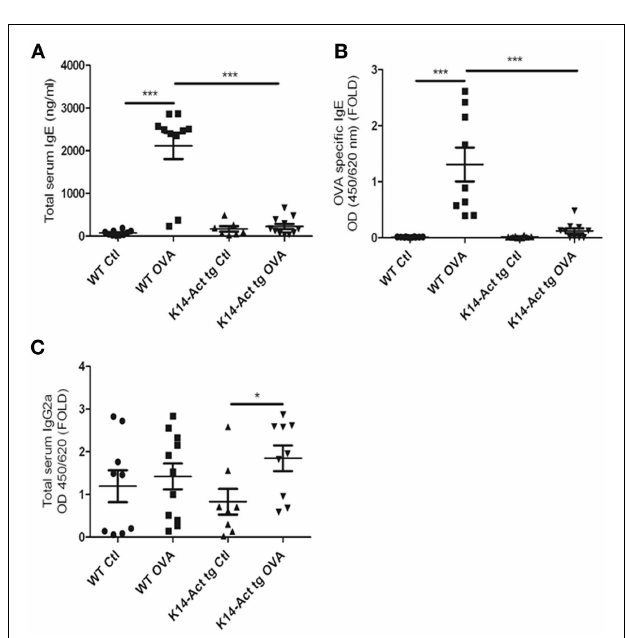
FIGURE 5 |Activin overexpression inhibits the production of IgEs after OVA treatment .WT and K14-Act mice treated with OVA or vehicle were sacrificed, and serum was collected.Total IgE (A) , OVA-specific IgE (B) , and total IgG2a (C) ELISA were performed as described in Section “Materials and Methods.”The data are presented as a scatter plot and mean values are shown ( n = 8–12). Statistically significant differences were calculated with the Mann–Whitney U -test ( p < 0.05* and p <